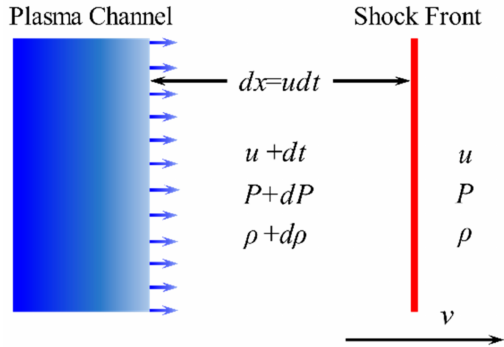
Figure 5. Plasma channel